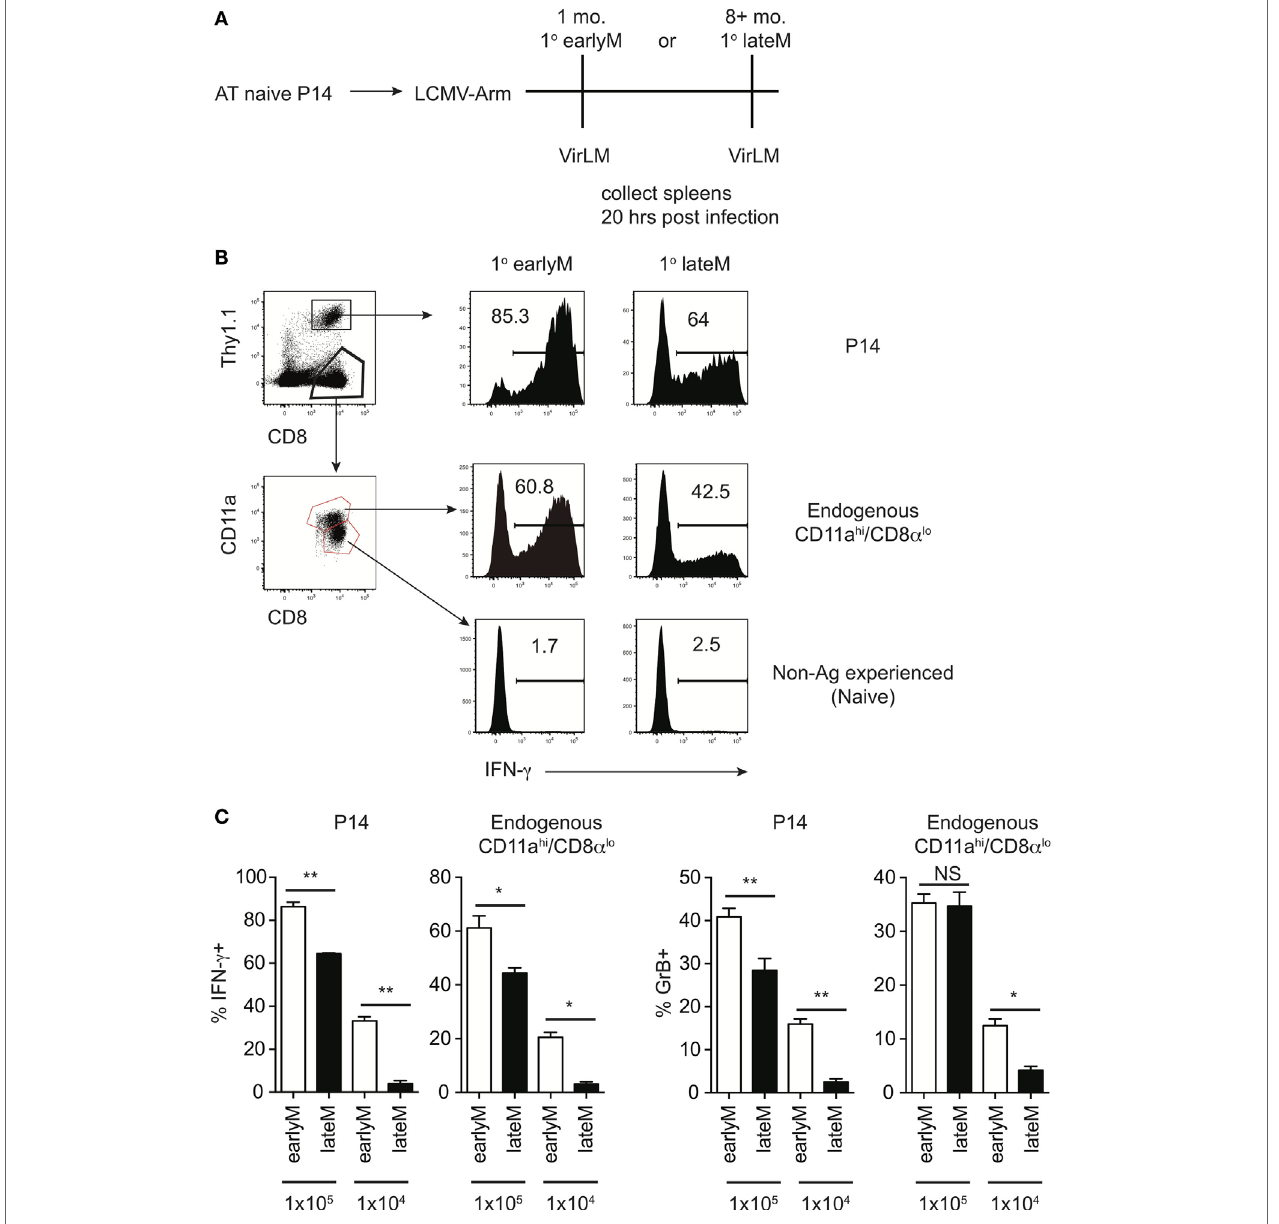
FigUre 1 | Bystander memory CD8 T cell responses decrease with time after initial antigen encounter. (a) Experimental Design. Mice received adoptive transfer of naïve P14 cells and were infected with LCMV-Armstrong. Either 30 days (earlyM) or > 8 months (lateM) after LCMV infection, mice were infected with Vir LM. Analysis was performed 20 h following Vir LM infection. (B) Representative histograms of bystander IFN- γ production by earlyM (left) or lateM (right) P14 cells (top), endogenous CD11a hi /CD8 α lo Ag-experienced cells (middle), or endogenous CD11a lo /CD8 α hi naïve cells (bottom). (c) Summary bar graphs of the percentage of earlyM and lateM P14 cells or endogenous Ag-experienced cells producing IFN- γ or GrB 20 h after Vir LM infection of the indicated dose. n = 5 mice/group. Representative data from 1 of 3 independent experiments. Error bars represent mean ± SEM. Unpaired t -test; NS, not significant, * p < 0.05, ** p <